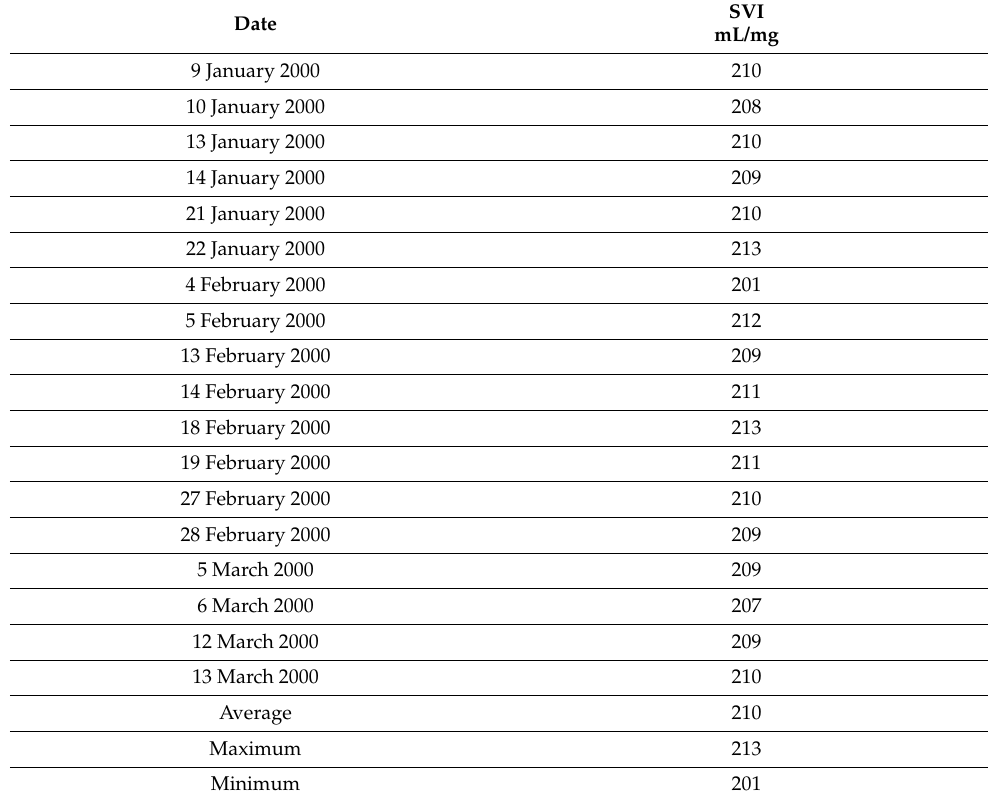
Table 5. SVI values for respective sampling days at plant